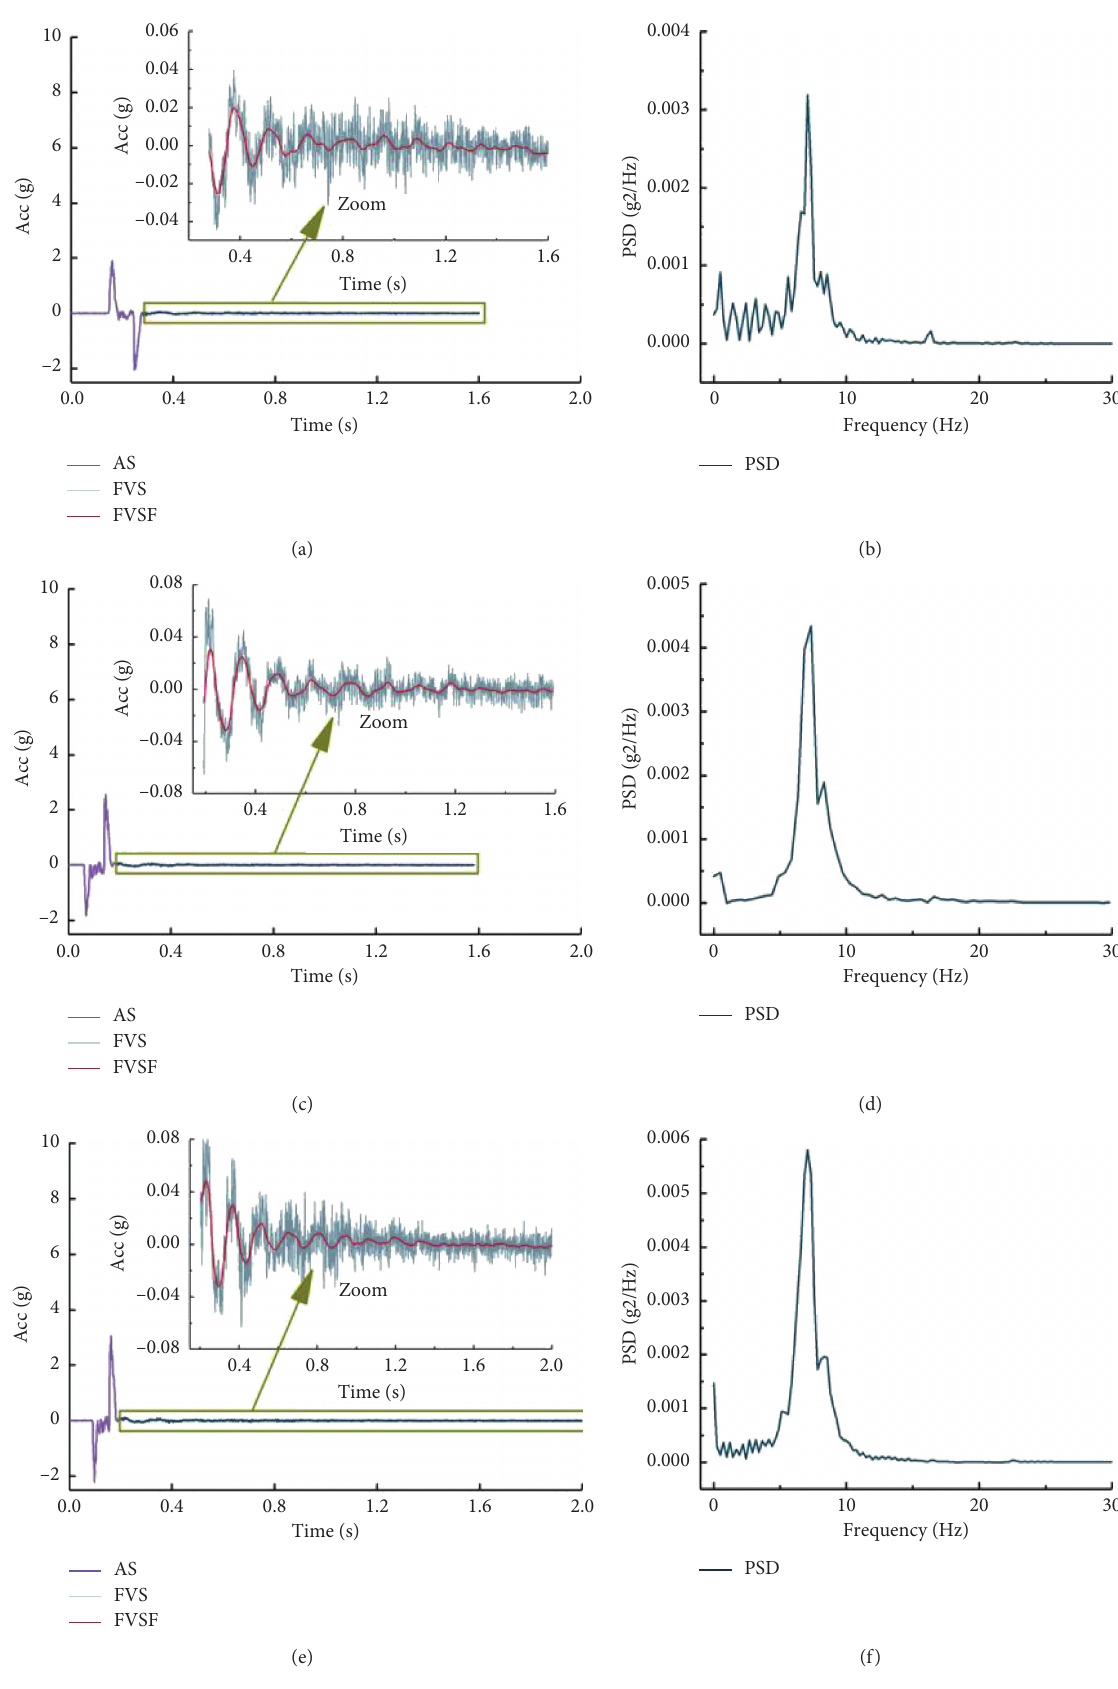
� 0.8m s − 1 and different a − . (a) and (b) max